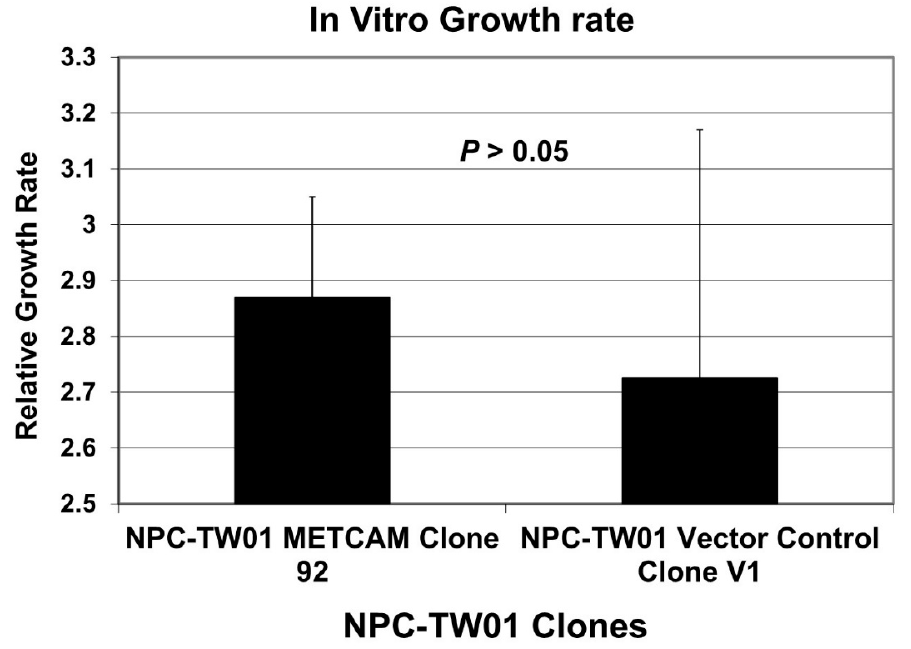
Figure 2. In vitro growth rates of the NPC-TW01 clones. Effects of the huMETCAM/MUC18 expression on the in vitro growth rate of the NPC-TW01 cells were carried out by determining the growth rate of the NPC-TW01 clones 92 and V1 by directly counting the cells at 24, 48, 72, and 96 h after seeding the cells, as described in the Section 4. The mean and standard deviation of the three relative growth rates for each clone were plotted.